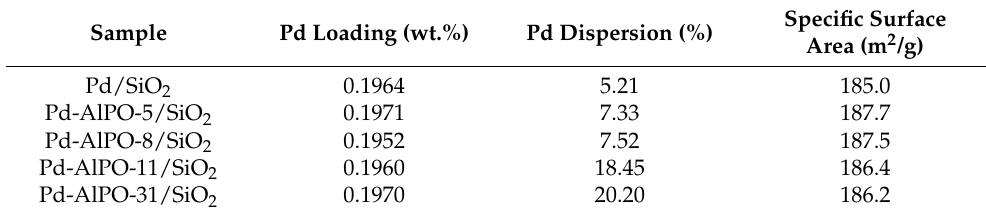
Figure 4. H 2 -TPR profiles of synthesized catalysts: (a) 0.2% Pd/SiO 2 ; (b) 0.2% Pd-AlPO-5/SiO 2 ; (c) 0.2% Pd-AlPO-8/SiO 2 ; (d) 0.2% Pd-AlPO-11/SiO 2 ; (e) 0.2% Pd-AlPO-31/SiO 2 . Table 3. Pd loading, dispersion and specific surface area of all